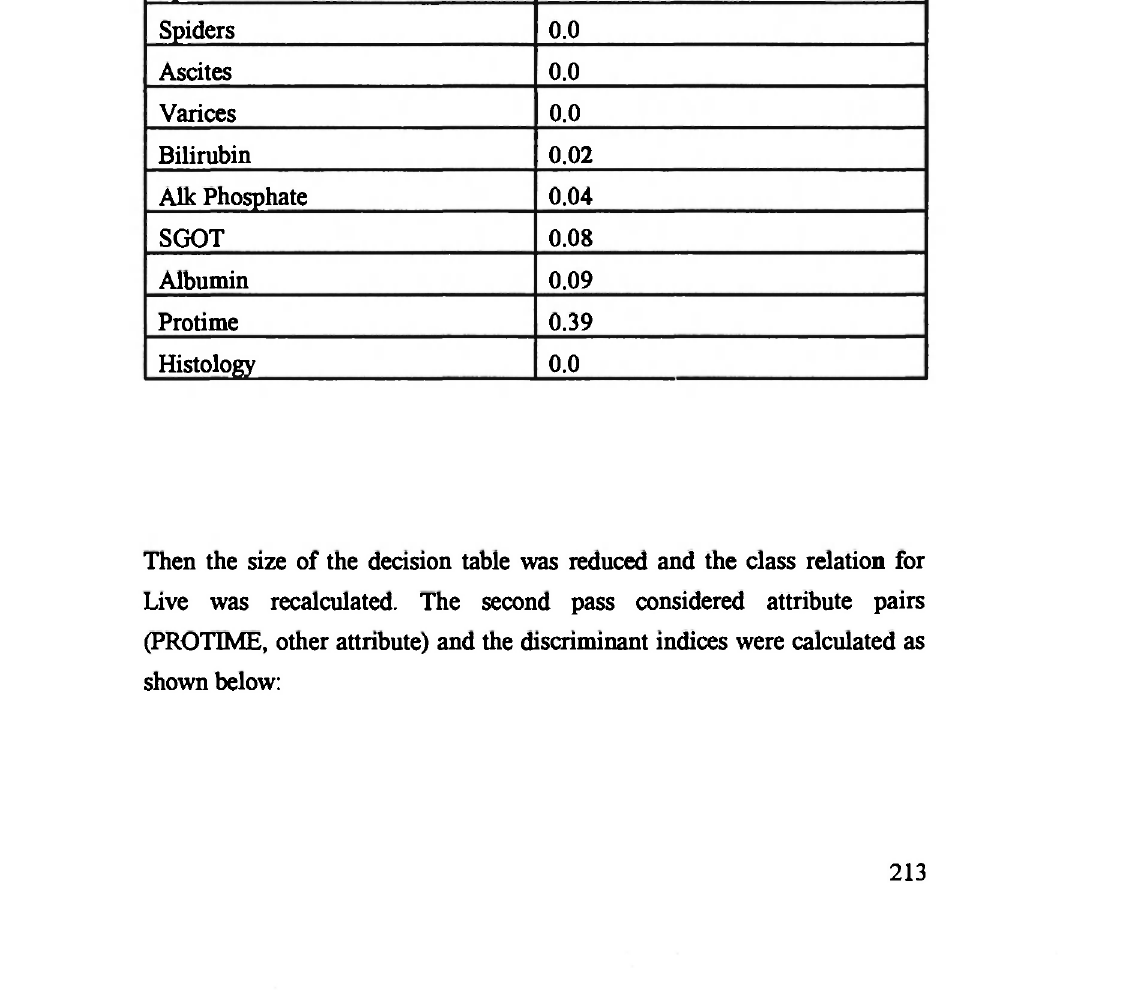
Table 5. Discriminant indices (first